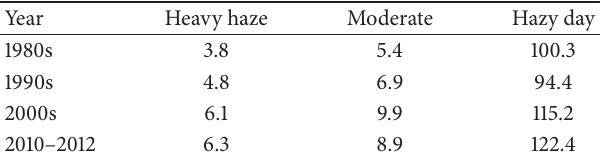
Table 1: Decadal change of haze/d ⋅ (per ⋅ station) −1